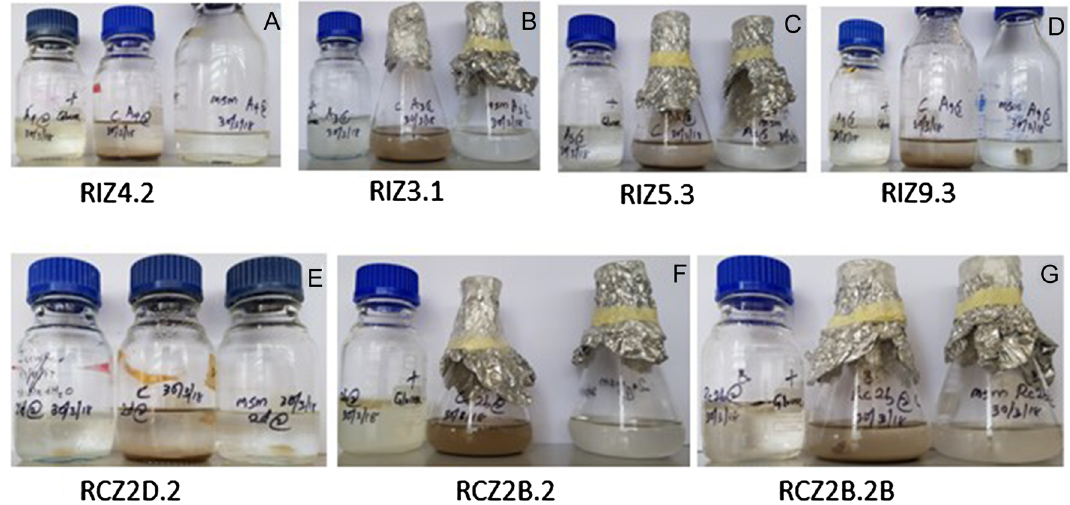
Fig. 2 Fungal activity in glucose broth (positive control), sub- bituminous coal medium and minimal salts medium (MSM) (negative control). A RIZ4.2, B RIZ3.1, C RIZ5.3, D RIZ9.3, E RCZ2D.2, F RCZ2B.2, G RCZ2B.2B